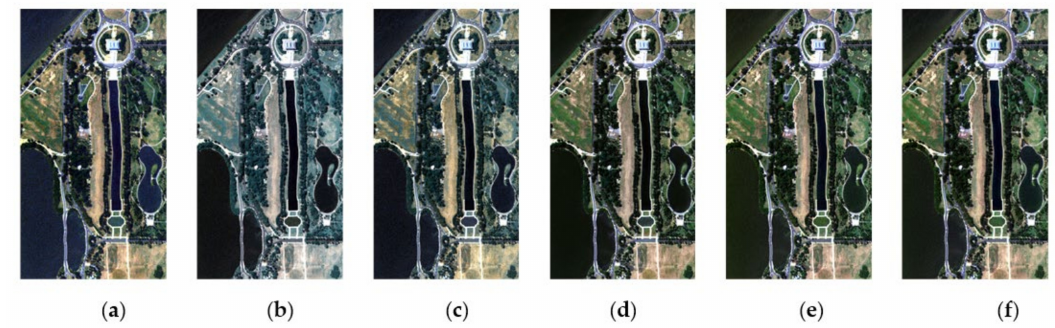
Figure 4. Fused images of Washington DC Mall. ( a ) CNMF; ( b ) JNMF; ( c ) DPLM; ( d ) TCNNF; ( e ) DiCNN; ( f ) CpCNN.